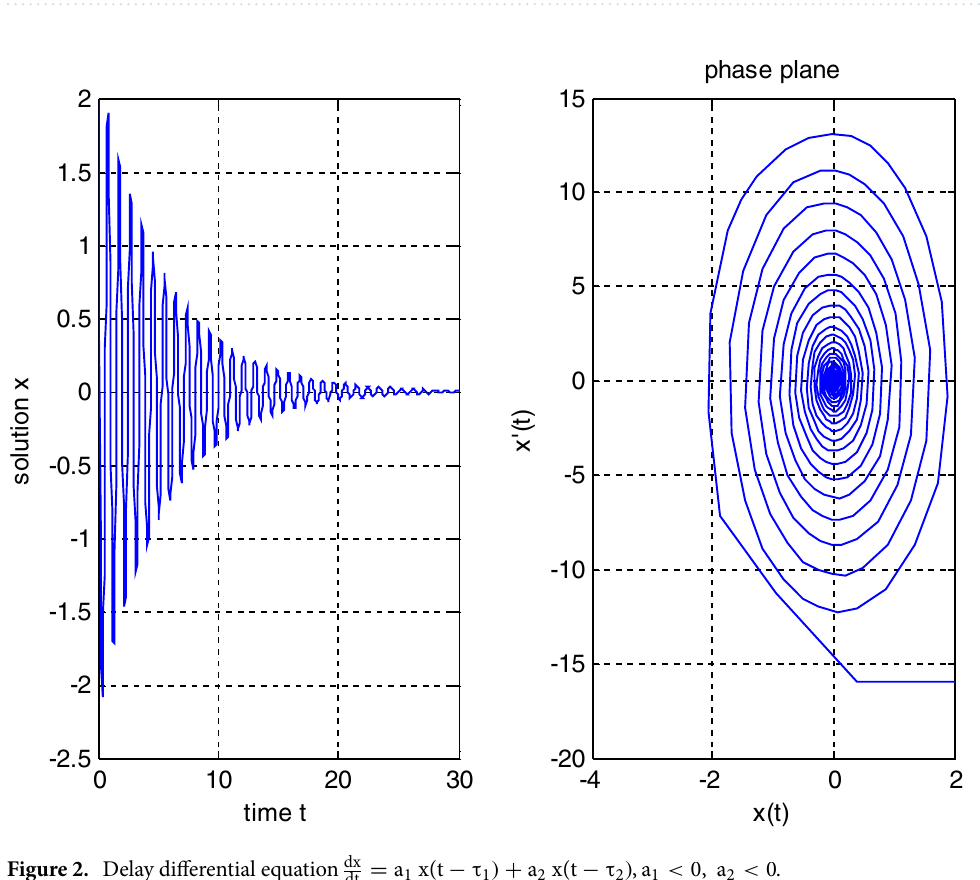
a 1 x(t a 2 x(t τ 1 ) τ 2 ) as damped harmonic oscillator. = − + −